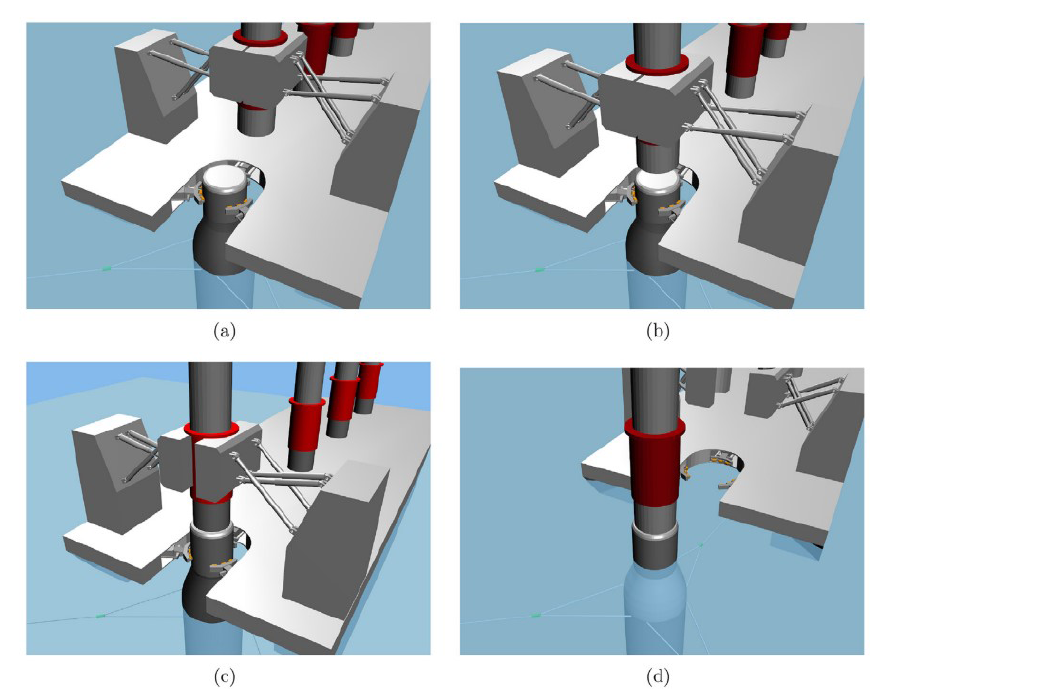
Figure 13. Stages in the installation of a wind turbine using the catamaran vessel: (a) transfer of the assembly, (b) monitoring of relative motion, (c) mating of the tower with the floater, (d) release of the foundation (Jiang et al., 2018; Hatledal et al.,